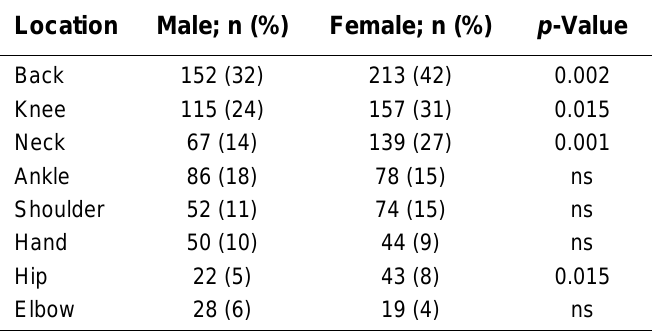
Students Who Reported Body Pain During the Last 3 Months (n = 600, 8 People Missing) Location Male; n (%) Female; n